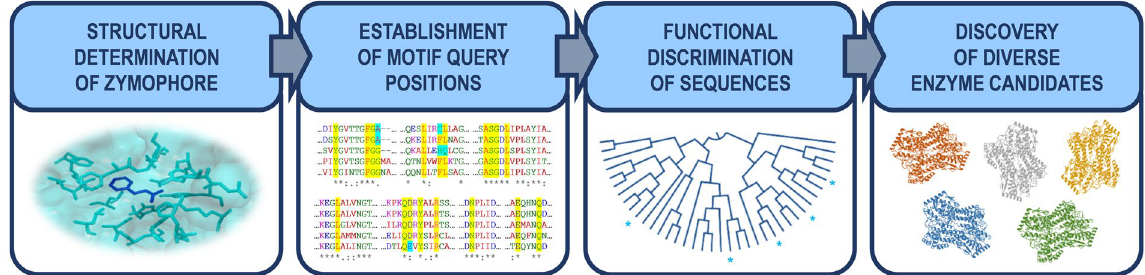
Figure 2. Flow diagram of the strategy employed to find new PAL enzymes for synthetic and medical